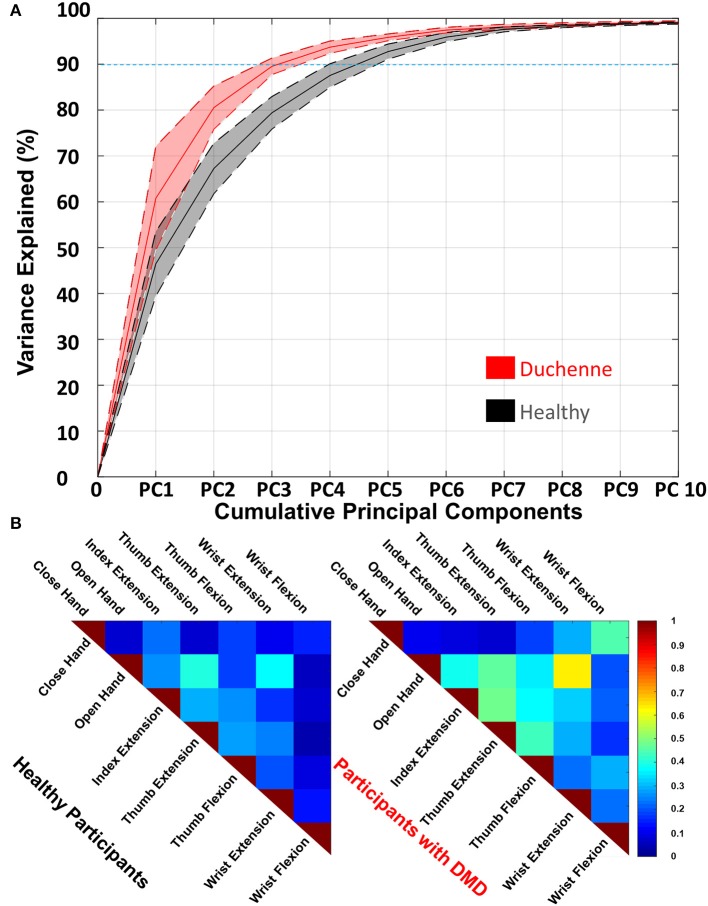
(A) The percentage of variance explained as a function of the number of cumulative principal components (PCs). More than 90% of the variance (blue dashed line) of the data of the participants with Duchenne muscular dystrophy (DMD) is explained by three PCs, while for the healthy by five. The full lines represent the mean and the dashed the standard deviation. For clarity, we include only up to 10 of the 63 components, as those explain more than 99% of the variance explained. (B) The averaged squared Pearson correlation between the seven gestures of both groups of participants in the form of a similarity matrix. High correlation shows similarity between the gestures. Both healthy and DMD participants show correlated gestures; however, this phenomenon is more prominent in the DMD participants. A high value shows high correlation where one is the maximum (diagonal). The number of unique comparisons between the seven gestures is 21 per participant.